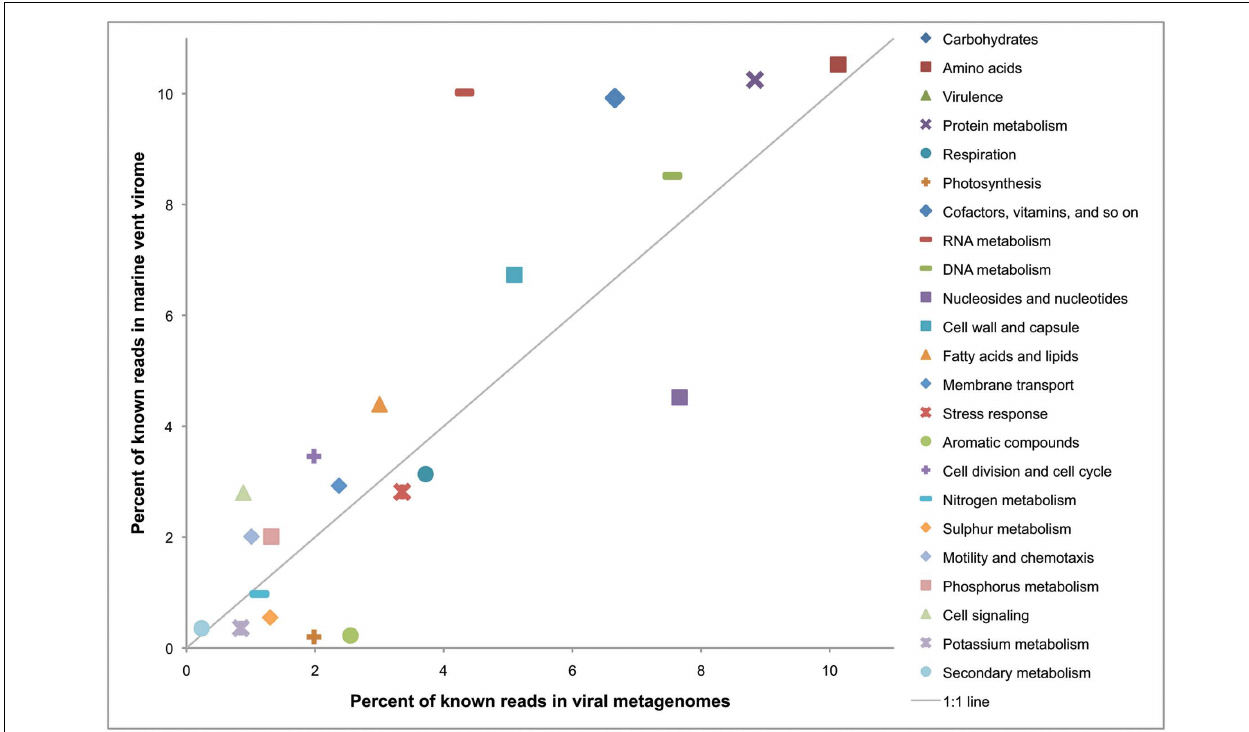
a 1:1 ratio between the vent metagenome and the other viral metagenomes. Metagenomes were analyzed with MG-RAST (Meyer et al., 2008) and annotated using the SEED subsystems